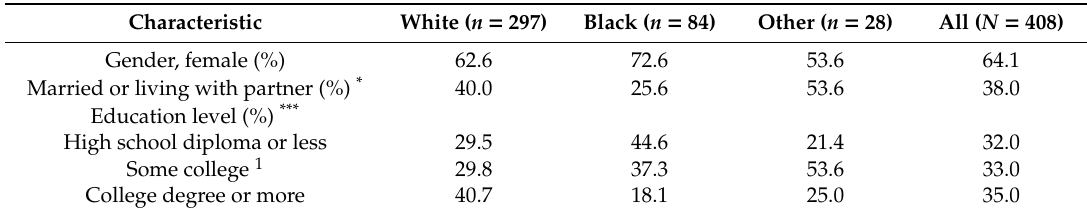
Table 1. Demographic characteristics, weighted ( N =